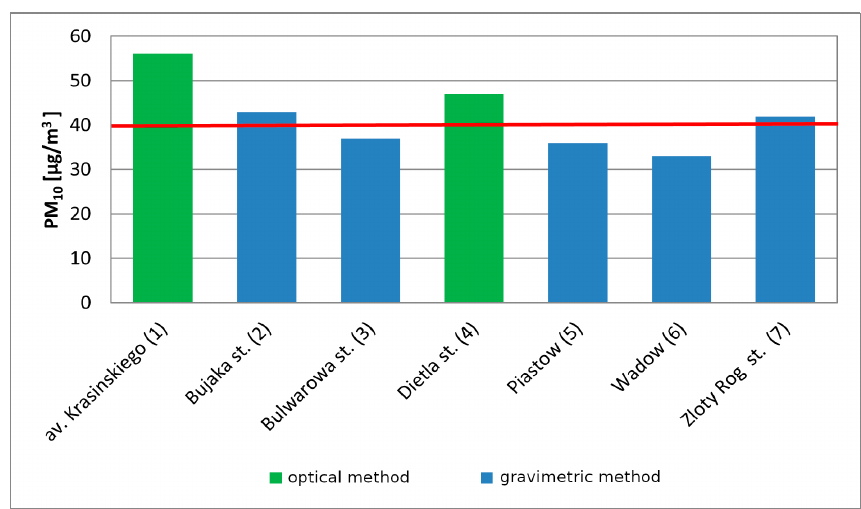
Figure 2. Concentration of PM 10 at WIOS stations in Krakow in 2017.